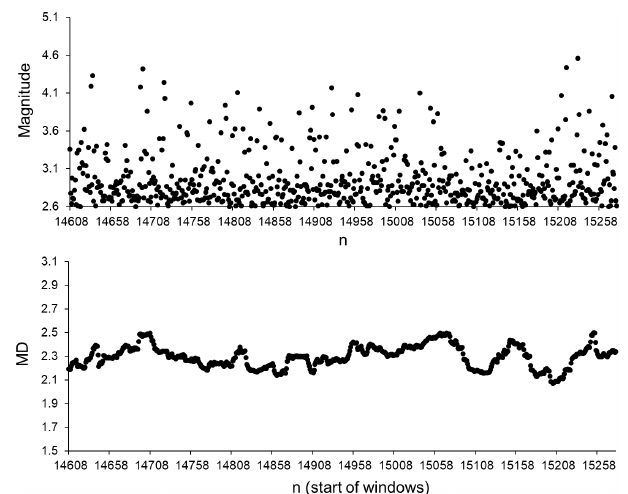
Figure 10. Magnitudes and MD values calculated for part of the SC catalogue after M 7 . 3 (28 June 1992, sequential number in SC cata- logue 13648) from 1 July 1992 (sequential number in SC catalogue 14608) to 5 July 1992 (sequential number in SC catalogue 15280). Average MD values are calculated for 50-data windows shifted by one data step; 90% of the earthquakes in this period occurred within a distance of 0.5–70km from the epicentre of M 7 . 3.